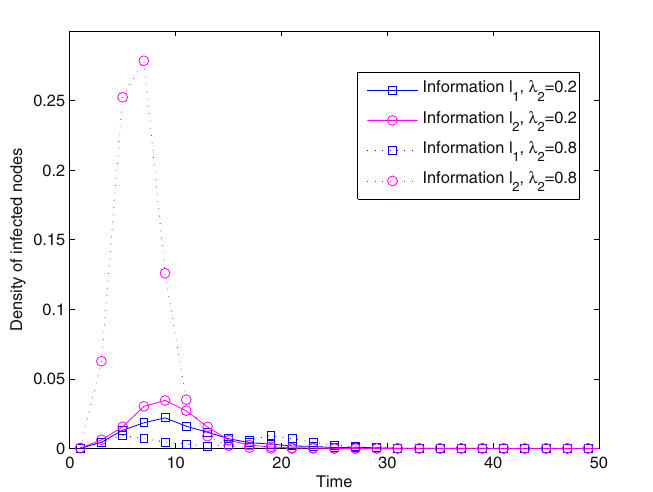
Figure 6. Density of refractory nodes with the method of blocking edges. The underlying network is the real network, λ = 0.2, and δ = 0.2. In the left plot, γ = 0.1, and in the right plot, γ = 0.4. Every plot is an average of 100 different simulations.